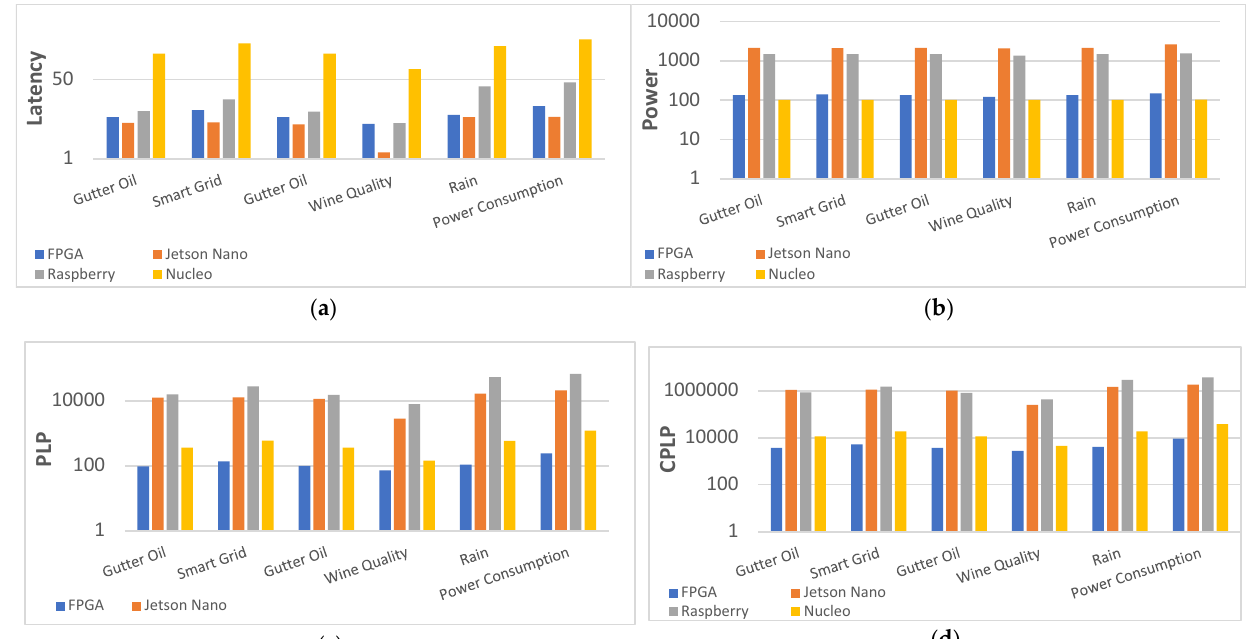
Figure 11. Comparison of performance (latency), power consumption, PLP, and CPLP for the six typical IoT endpoint datasets with different algorithms when implemented on FPGA and embedded platforms. ( a ) Comparison of performance (latency). ( b ) Comparison of power consumption. ( c ) Comparison of PLP. ( d ) Comparison of CPLP.